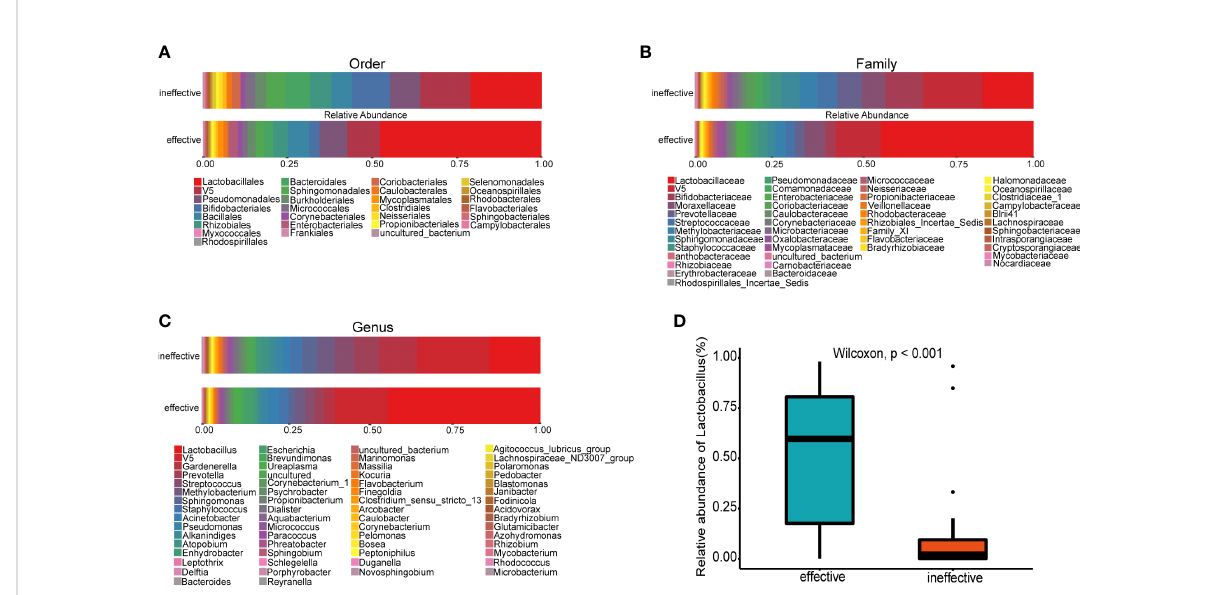
TABLE 2 Comparisons of median relative abundances of bacteria (genus) in effective group and ineffective group. Relative abundance (%) Effective group